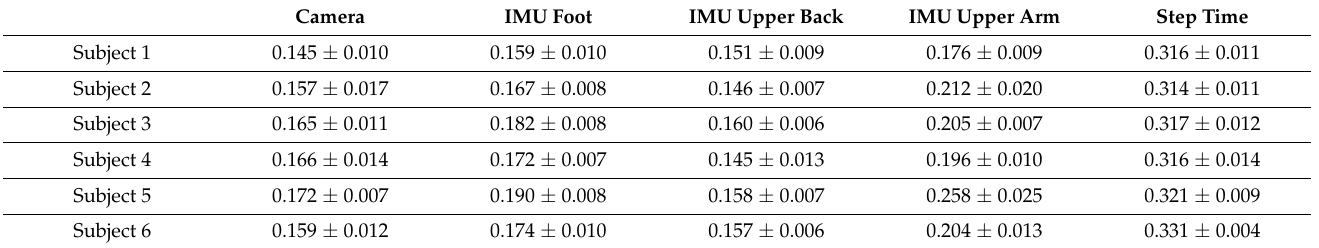
Table 3. Ground contact time in seconds (mean ± std) for the different subjects using the different sensors. The right-hand column shows aggregated results for the step time identified using the cam- eras.